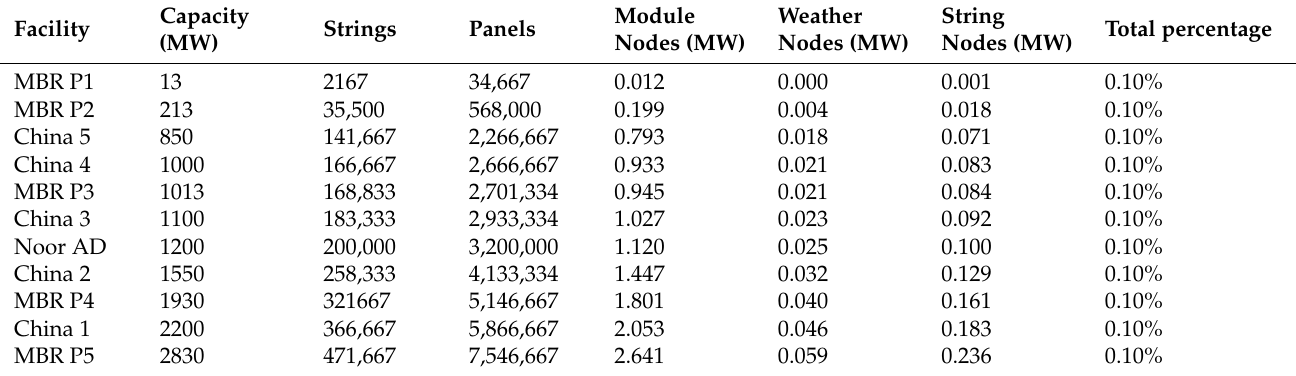
Table 5. Estimated power